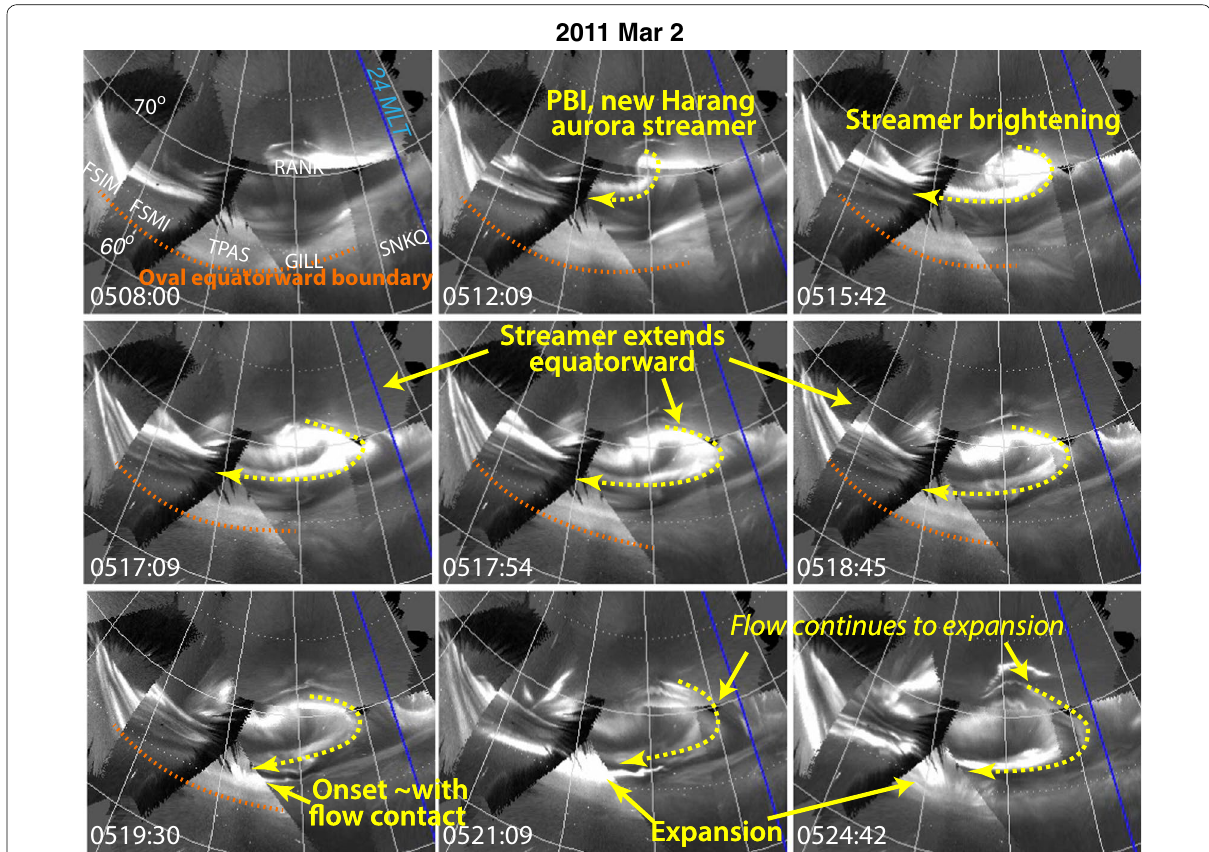
Fig. 4 Example of a Harang streamer on 2 March 2011 in the same format as Fig. 1 showing the streamer’s leading edge moving to very near the onset